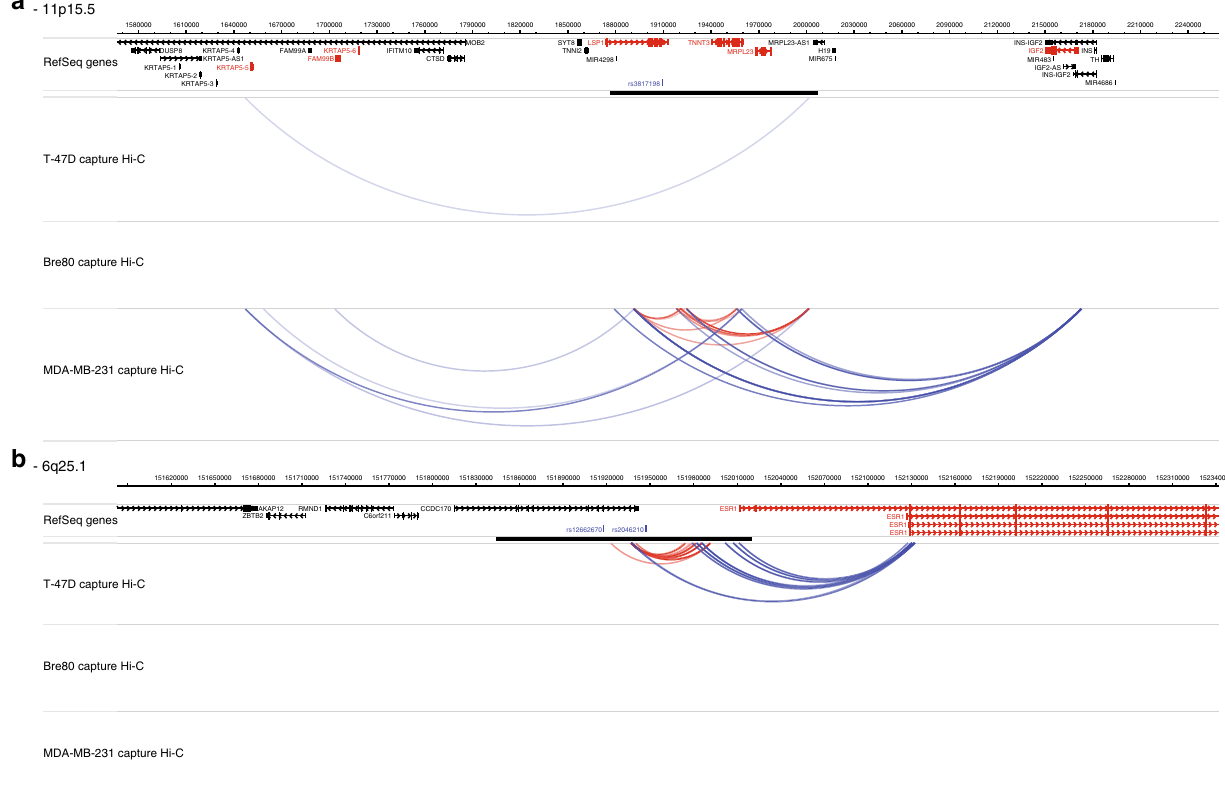
Fig. 3 Interaction peaks at 11p15.5 and 6q25.1 in T-47D, Bre80 and MDA-MB-231 cell lines. Interaction peaks and genomic features are as described in Fig. 2. a 11p15.5-rs3817198 ( LSP1 ) locus. At this locus, which is associated with ER + disease there are multiple interaction peaks targeting KRTAP5-5 (~300 kb centromeric), LSP1 (within the capture region) and IGF2 (~ 250 kb telomeric) in the ER − cell line MDA-MB-231 but just a single IP targeting KRTAP5-5 in the ER + cell line T-47D and none in Bre80. b 6q25.1-rs2046210 ( ESR1 ) locus. At this locus, which is associated with predominantly ER − disease, there are multiple interaction peaks originating from the capture region, overlapping the ESR1 promoter in the ER + breast cancer cell line T-47D, but not in the ER